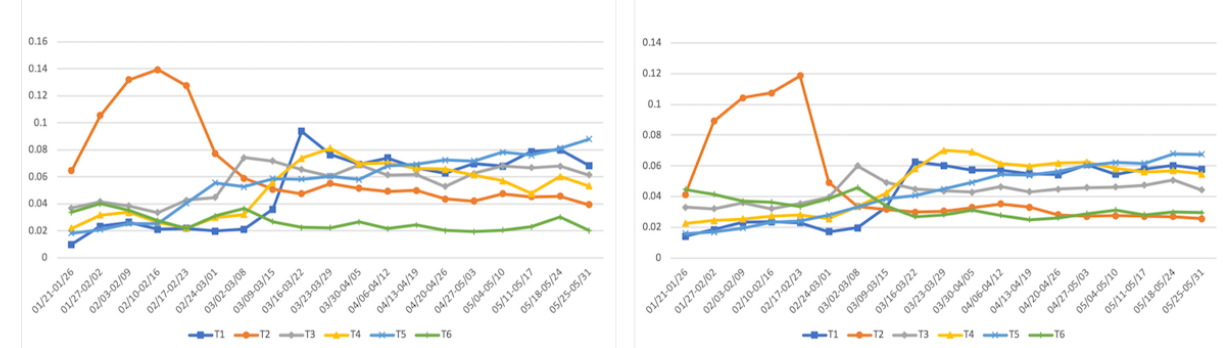
Figure 3. Changes of six public health–relevant topics over time. T1: social and physical distancing; T2: air travel and regional border restrictions and outbreaks; T3: handwashing and preventive measures; T4: the need to stay home and impact of COVID-19 on essential workers and family; T5: number of tests and cases; T6: masks and face